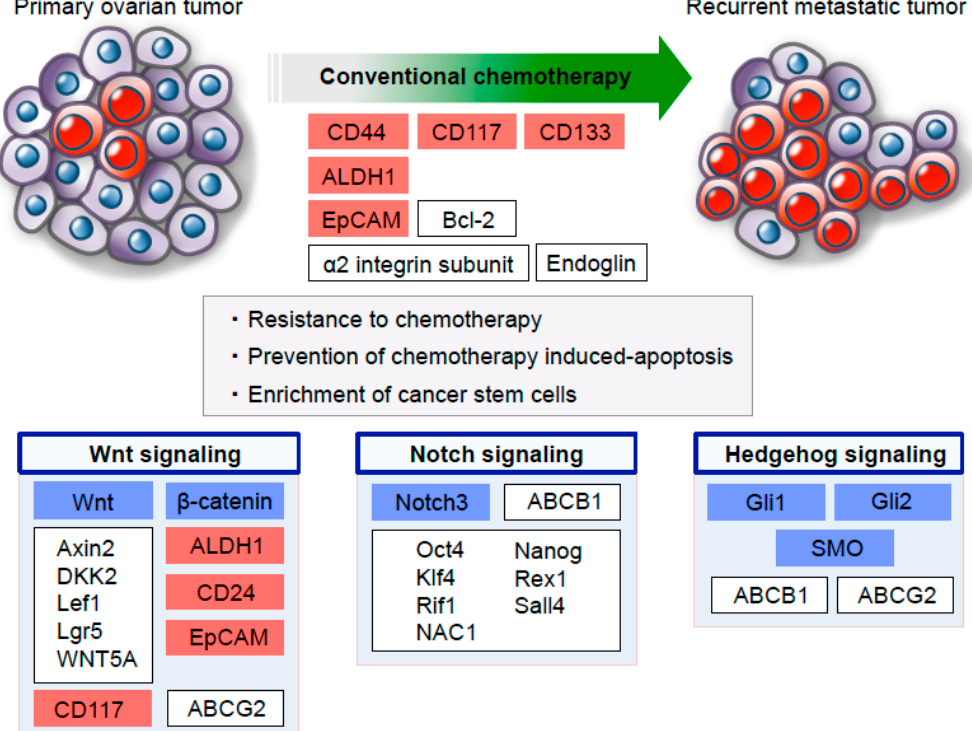
Figure 2. Schema of an ovarian cancer stem cell model for chemotherapy resistance. A subpopulation of ovarian cancer stem cells is able to survive conventional chemotherapy and is closely correlated with the development of recurrent metastatic tumors after chemotherapy. In fact, chemotherapeutic drugs induce the enrichment of ovarian cancer stem cells at metastatic sites, and metastasized ovarian cancer stem cells manifest enhanced chemoresistance by regulating various stem cell signaling pathways, including Wnt, Notch, and Hedgehog. Cancer stem cell markers are highlighted in red, and embryonic developmental signaling pathways are highlighted in blue.